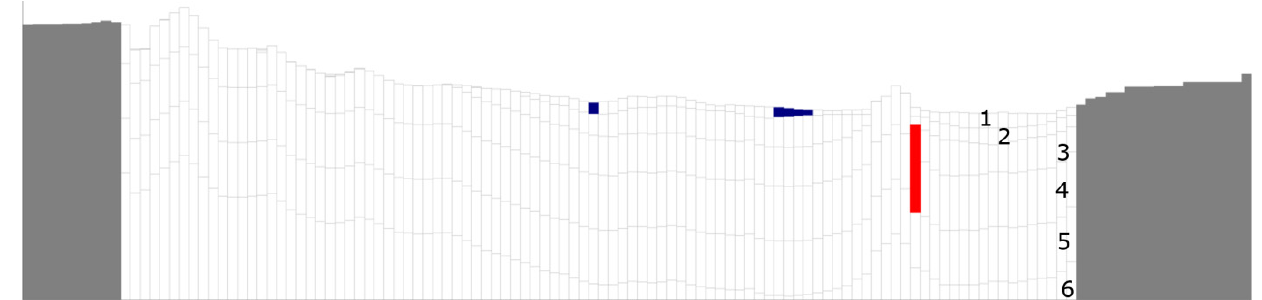
Figure 6. Scheme of vertical discretization into model layers (layer numbering was marked); example cross-section along column 80, vertical exaggeration—10. The meaning of the colors in the cells: white—active, grey—inactive, blue—first-type boundary conditions (some rivers), red—second-type boundary condition (exploitation wells).